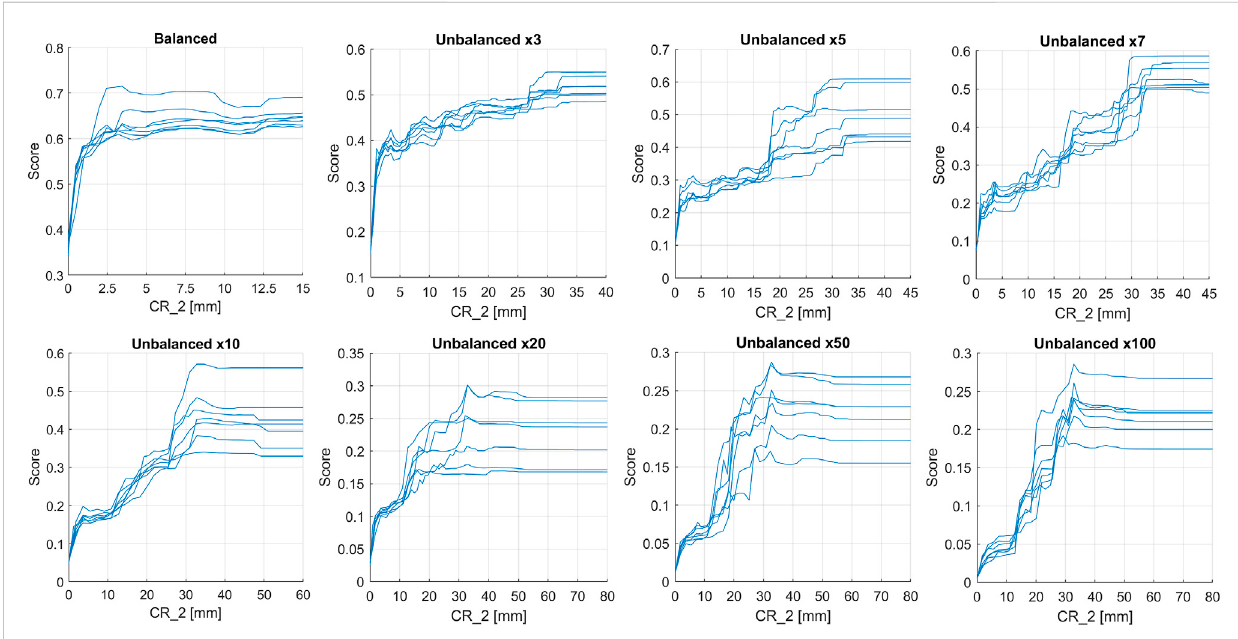
FIGURE 12 PDPs of the CR_2 variable obtained by applying the third test, with only the selected cumulative rainfalls, and using a balanced database or different degree of imbalance (x3, x5, x7, x10, x20, x50 and